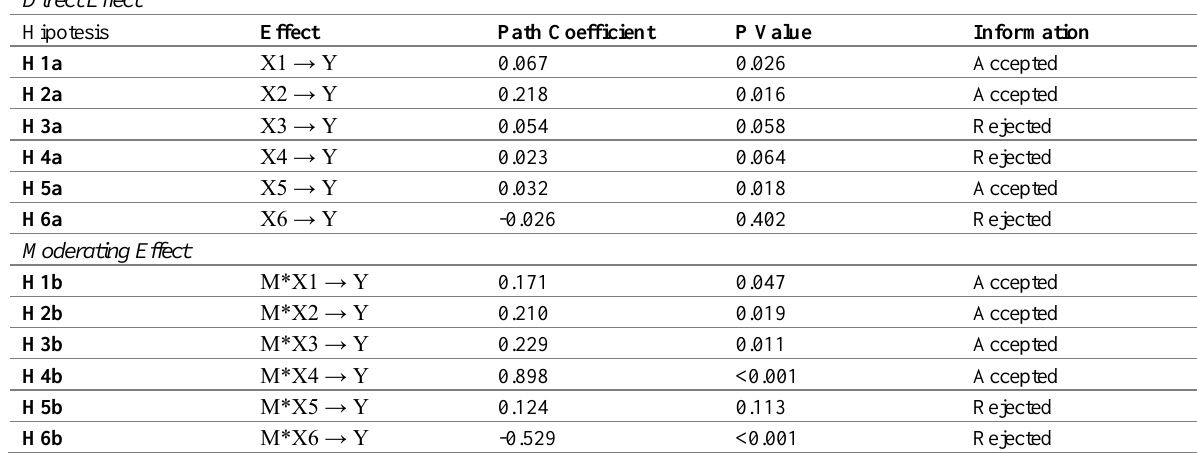
Table 8: Hypothesis Test